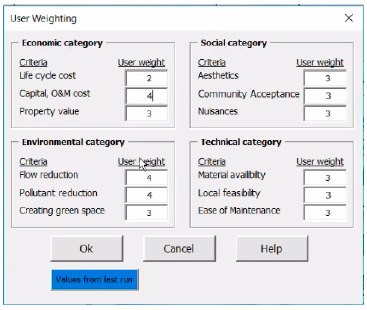
Figure A13. User weighting option